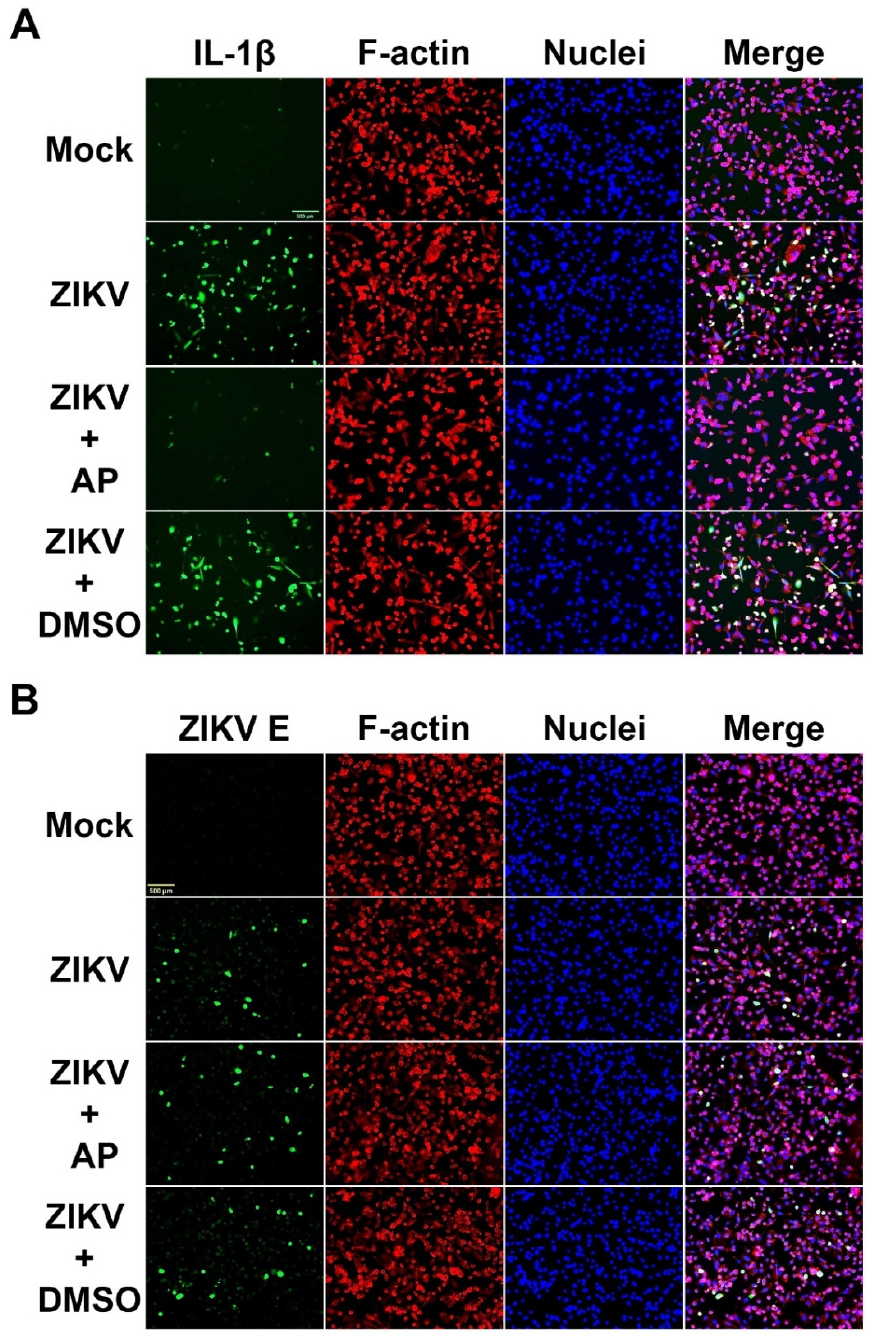
Figure 4. Immunofluorescence study examining the effects of AP on intracellular production of IL-1 β ( A ) and ZIKV E protein ( B ) in ZIKV-infected THP-1 cells (5 MOI) for 48 h. Green is IL-1 β or ZIKV E protein in the cells. Filamentous (F) actin (red) was stained with DyLight TM 594-Phalloidin, and nuclei of cells (blue) were stained with DAPI. Scale bar = 500 μ m.